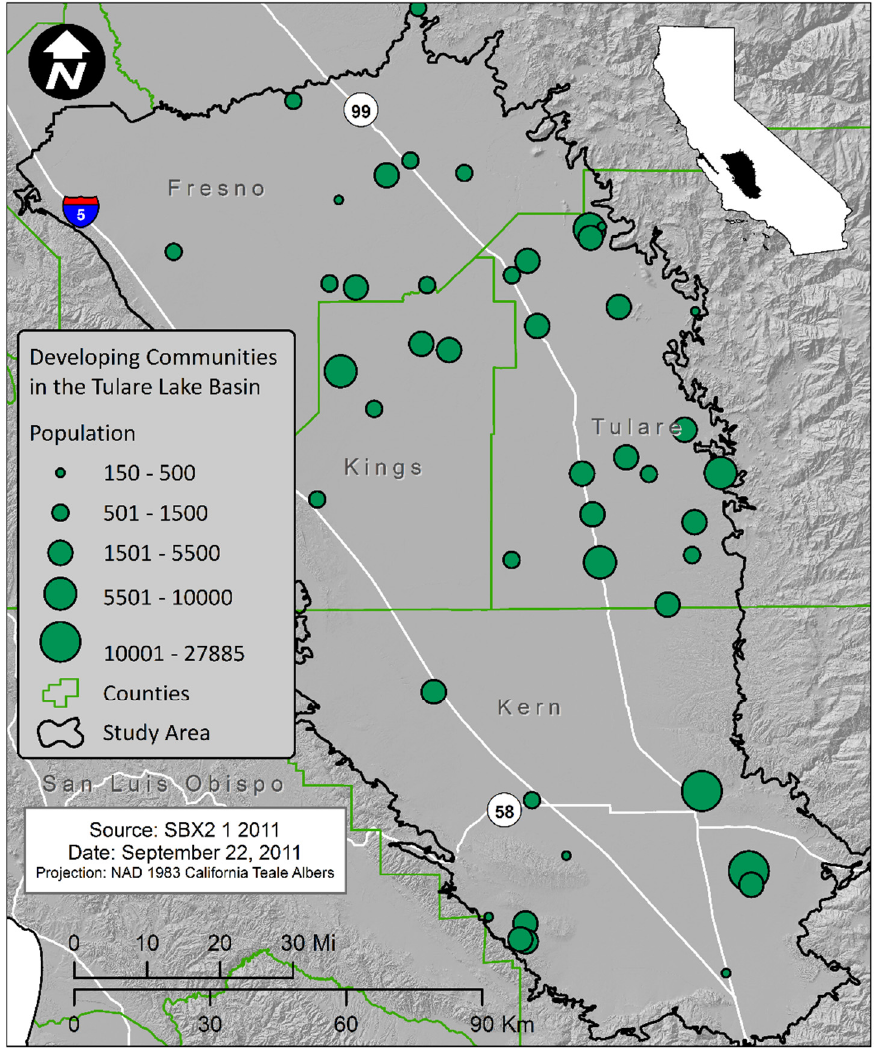
Figure 1. Developing Communities of the Tulare Lake Basin, California, CA,